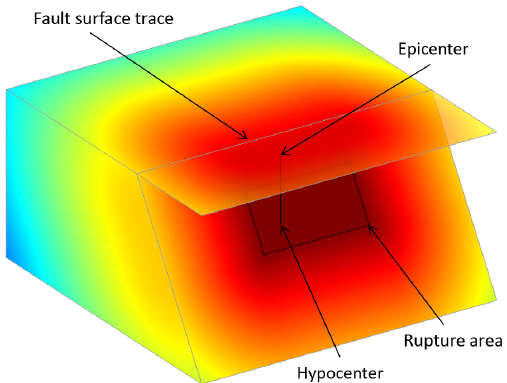
Figure 2. Illustration of a fault plane and wave intensity. The earth- quake nucleates at the hypocenter, but waves radiate out from every point of the rupture area. For this reason as well as other factors (e.g., local site conditions and water bodies), the epicenter is not necessarily in the center of the strong shaking